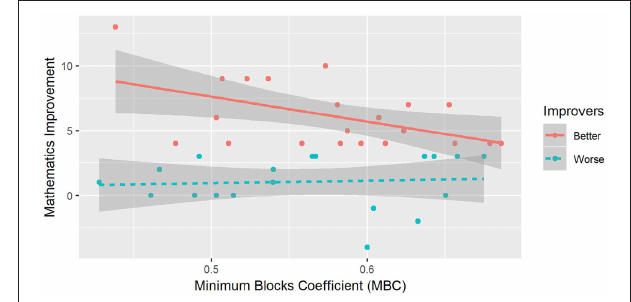
FIGURE 6 | Minimum Blocks Coefficient by mathematics improvement for better and worse improvers. We applied a linear model to data points with a 95% confidence level.